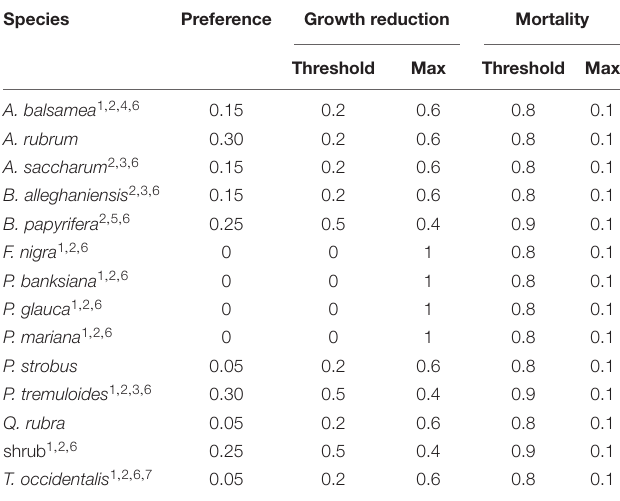
TABLE 2 | Species-specific model parameters for moose browsing preference and effects of browsing on growth and mortality. Species